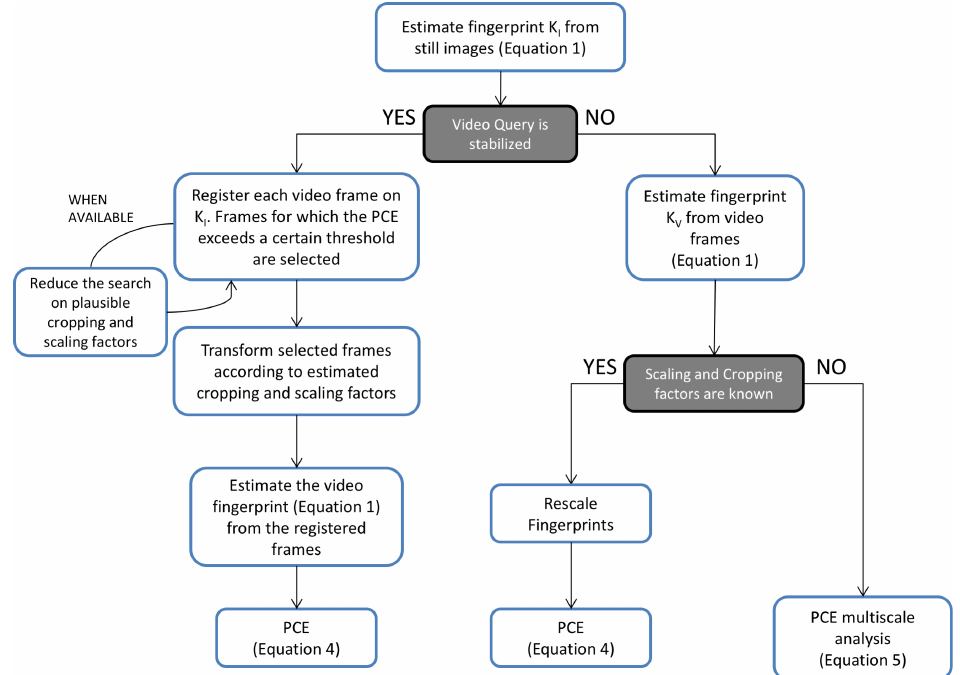
Figure 2. Hybrid reference-based Source Identification (HSI) pipeline to source attribution of a query